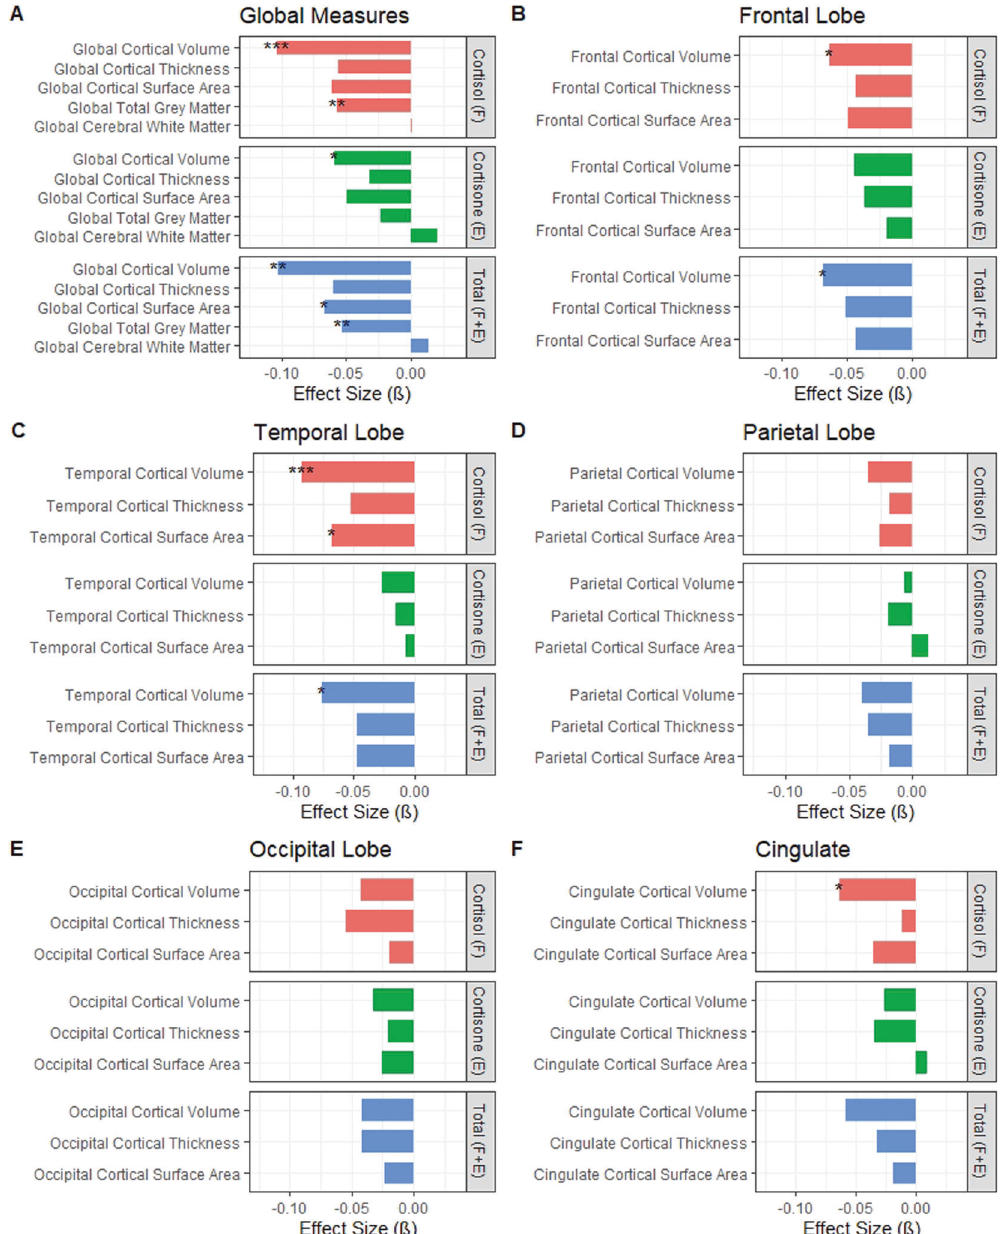
Fig. 2 Standardised effect sizes ( ß ) of hair cortisol (F), cortisone (E) and total glucocorticoid (F + E) associations with global and lobar structural neuroimaging phenotypes. A Global neuroimaging measures, B frontal lobe neuroimaging measures, C temporal lobe neuroimaging measures, D parietal lobe neuroimaging measures, E occipital lobe neuroimaging measures, and F cingulate neuroimaging measures. * P < 0.05, ** P < 0.01, *** P <